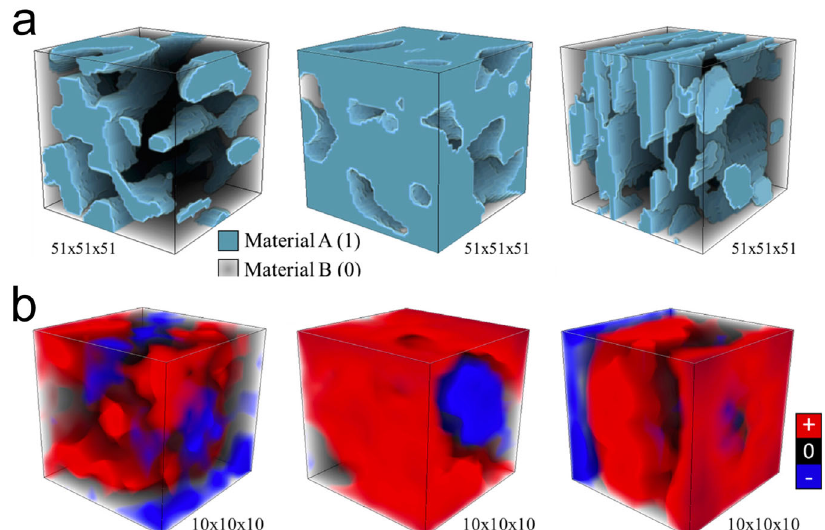
Fig. 10 CNN model parameter direct inspection example. The authors design a simple 3D CNN to predict effective elastic properties of high contrast composites from synthetic microstructures. a 3D microstructure data, colored by material phase. b CNN fi lter weights, colored according to their sign (near zero values are rounded to zero). Positive weights in the CNN fi lters (red) suggest a preference for a structural pattern and negative weights (blue) penalty deviations. A comparison between input microstructures and CNN fi lter weights shows that CNN fi lters can learn simpli fi ed characteristics of the input microstructure. Figure reprinted from ref. 86 with permission. Copyright 2018 Elsevier.